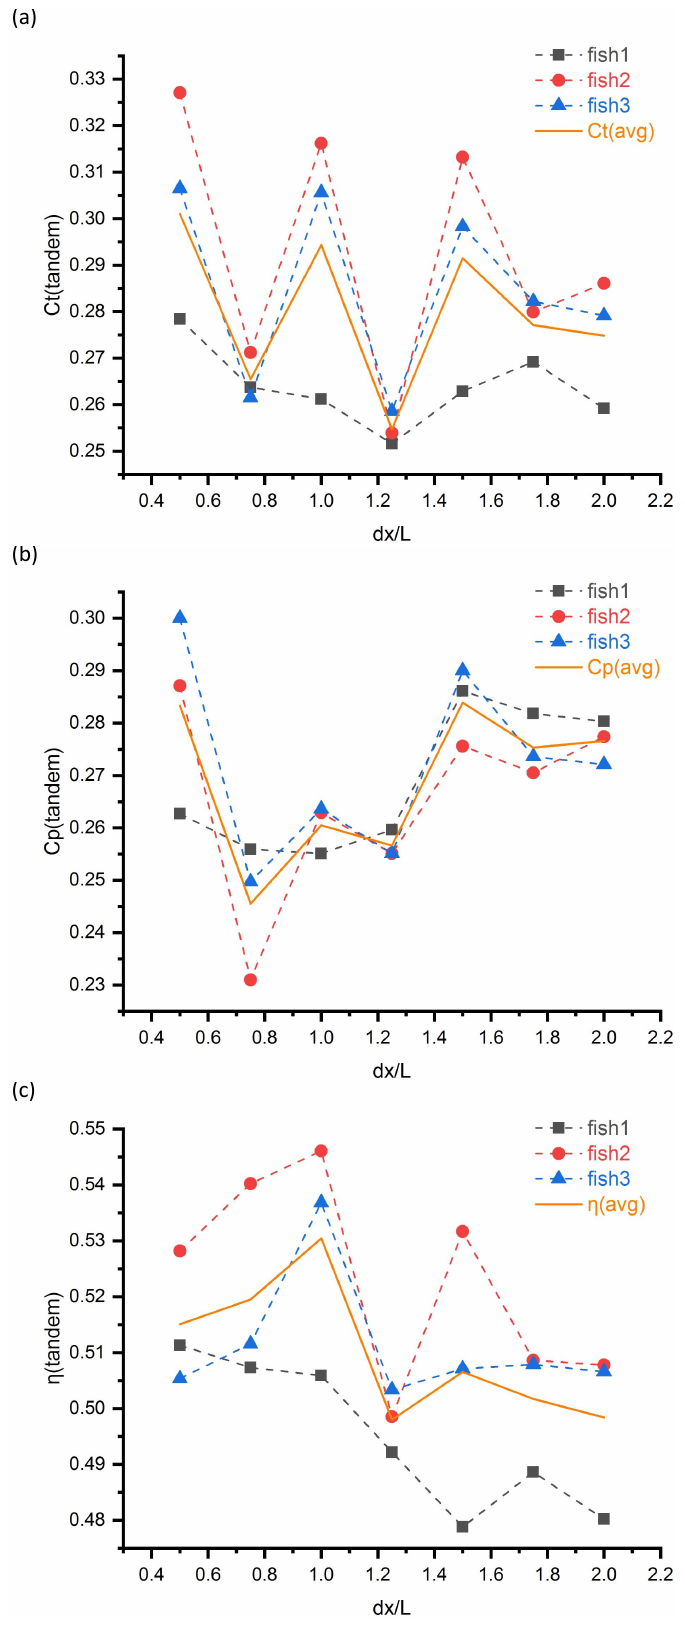
Figure 10. Results of the tandem swarm: ( a ) non-dimensional thrust coefficients C t , ( b ) non-dimensional lateral power loss coefficients C p , ( c ) the Froude efficiency η